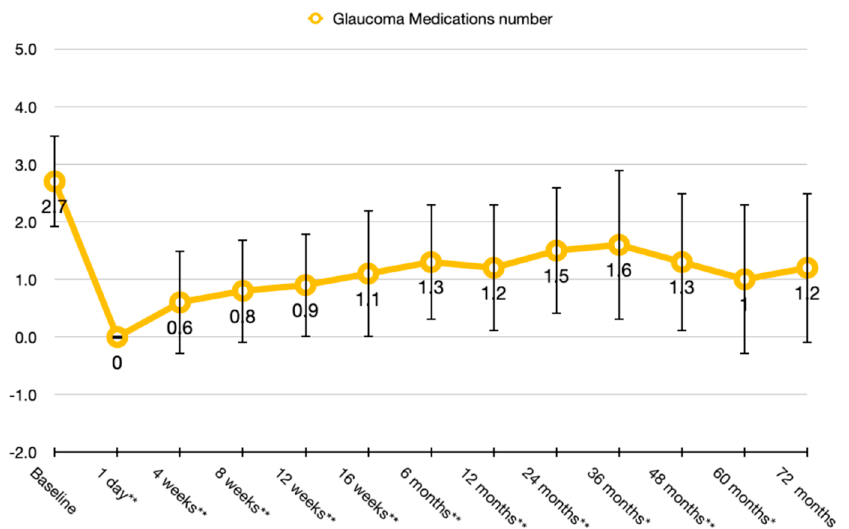
Figure 2. Glaucoma medication trend after the second Ahmed Glaucoma Valve (AGV) implant. Representation of the number of glaucoma medications. The reduction was statistically significant (** p < 0.001; * p < 0.05) at each time point until month 60.